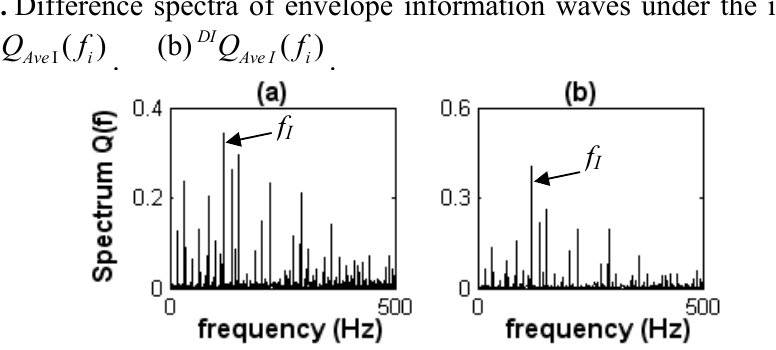
Figure 15. Difference spectra of envelope information waves under the inner-race defect state. (a)